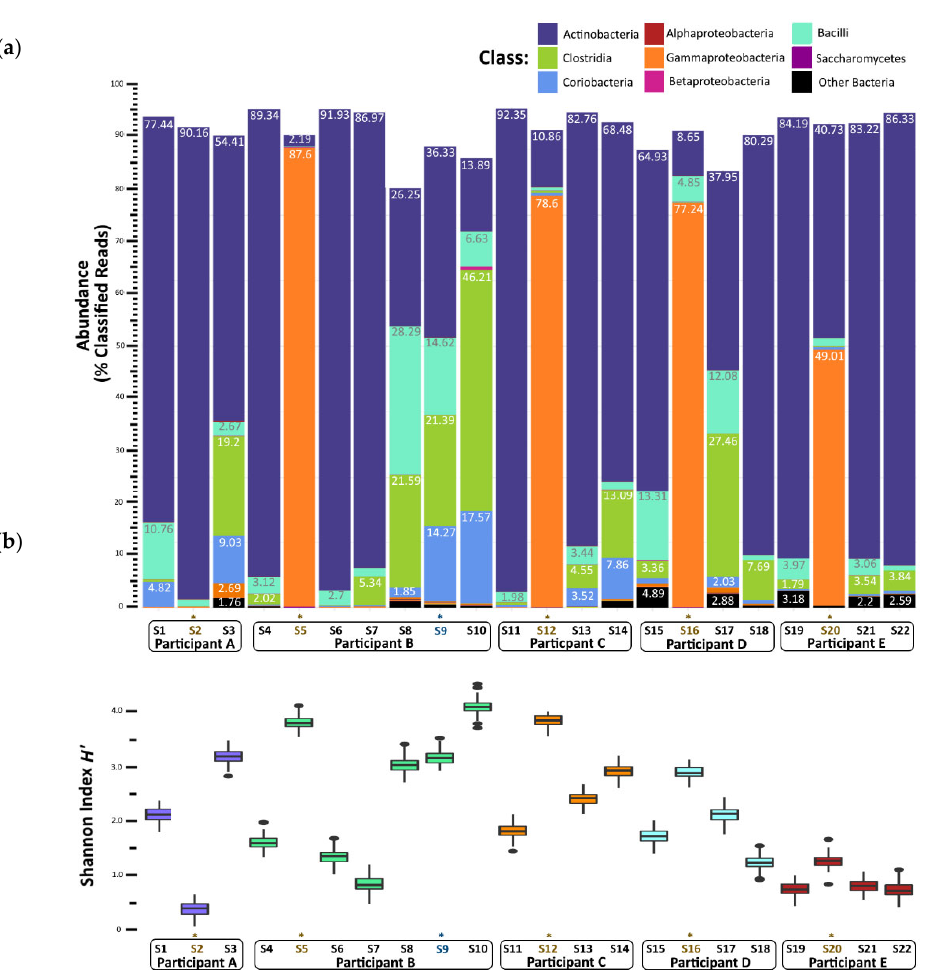
Figure 2. Gut microbiome changes in composition and diversity before, during, and after norovirus ‐ associated AGE. ( a ) Percentage abundance changes at the Class rank. ( b ) Alpha diversity measured by the Shannon entropy H’ Index. An * and brown colored text represent the samples collected during the AGE episodes. For Patient B, a second norovirus infection occurred, indicated by the blue text. Numbers following “S” indicate the sample identifier for metagenomic data.